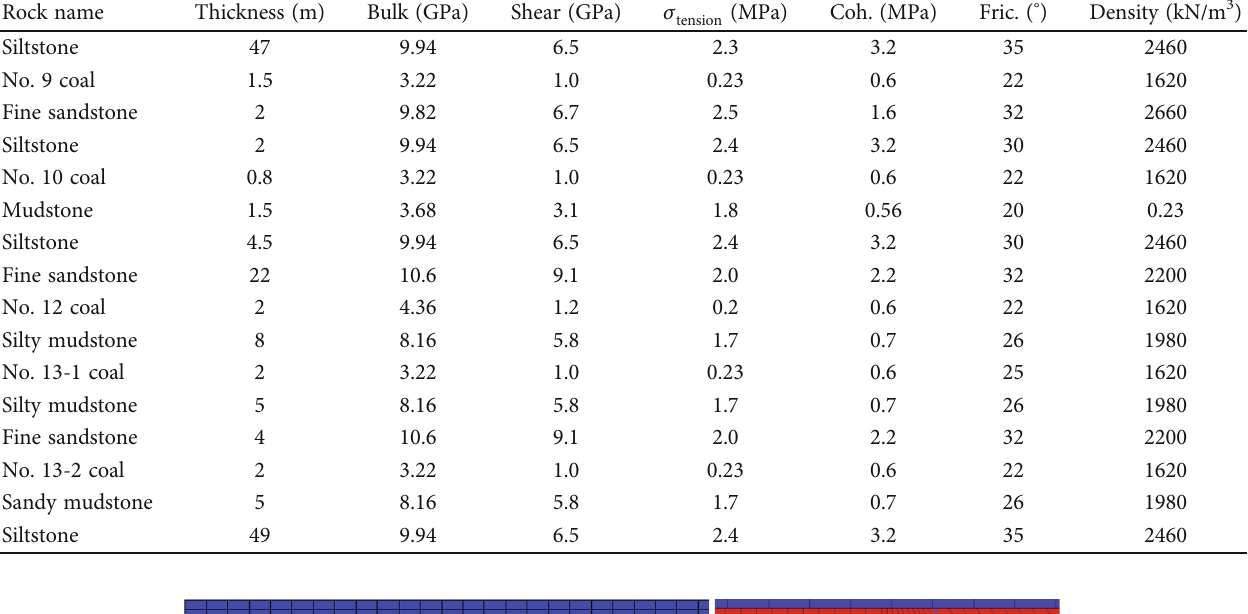
Figure 3: Sketch of the engineering drawing ( fl at and section). Table 1: Rock mechanical parameters of each rock layer.